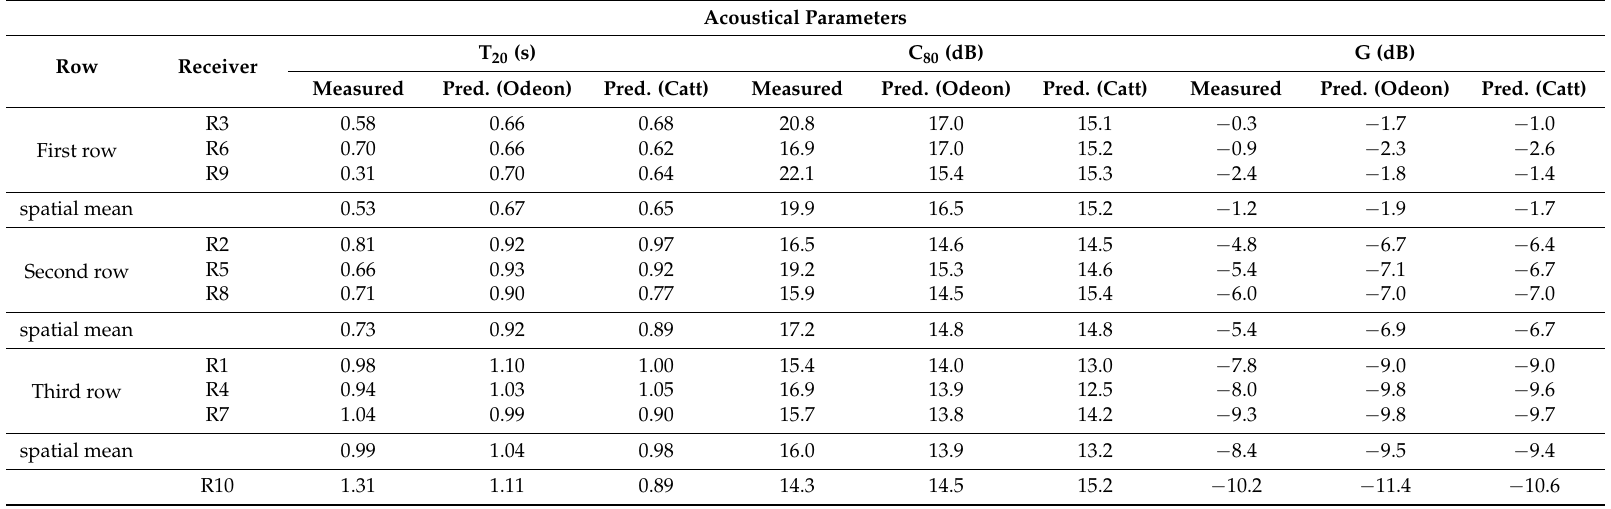
Table 4. Mean values of the measurements and simulations for the T 20 , C 80 , and G acoustical parameters for the source in position S1. The data refer to the averages of the 500 Hz and 1 kHz octave bands and to the repetitions for the same receiver position. Spatial means refer to receivers on the same